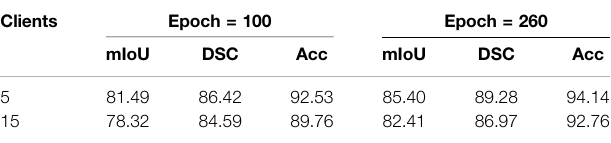
TABLE4| PerformanceoftheFLglobalmodelfor5clientsand15clientsatepoch = 100 and epoch = 260. Clients